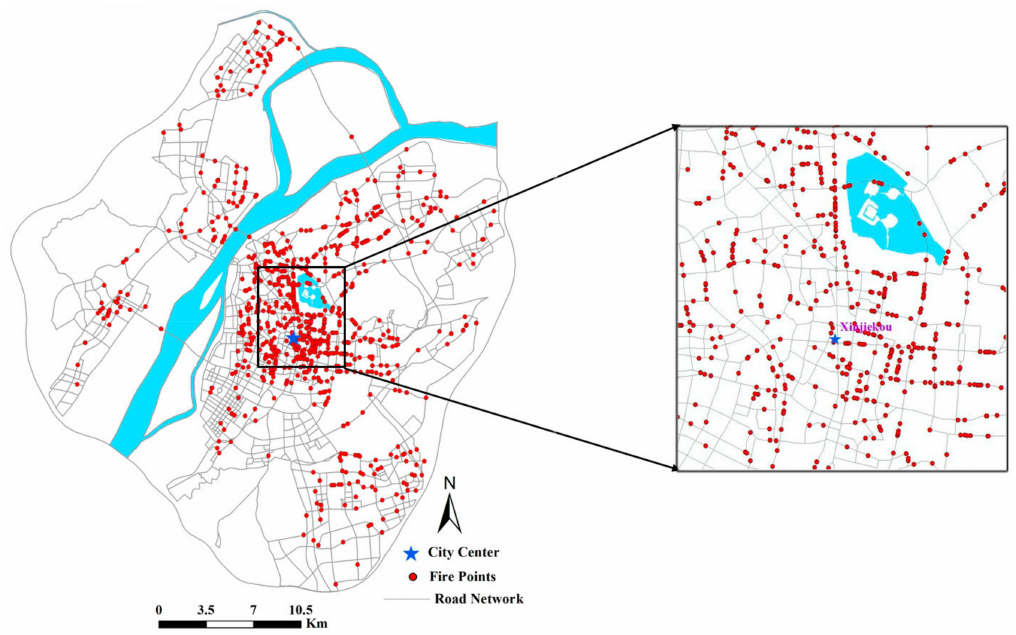
Figure 6. Distribution of fire points after matching under network space in the study